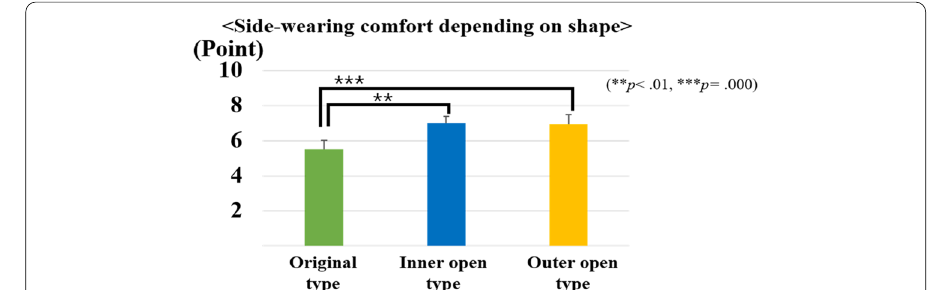
Fig. 7 Side-wearing comfort of pads depending on shape (Bonferroni post hoc analysis method)